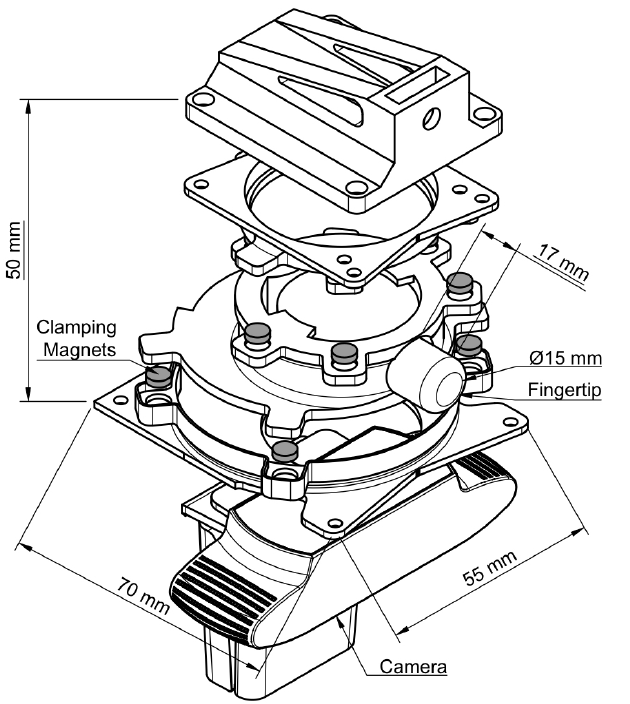
Figure A3. Robot Gripper and the exploded view of the modular sensor enclosure and photoelastic